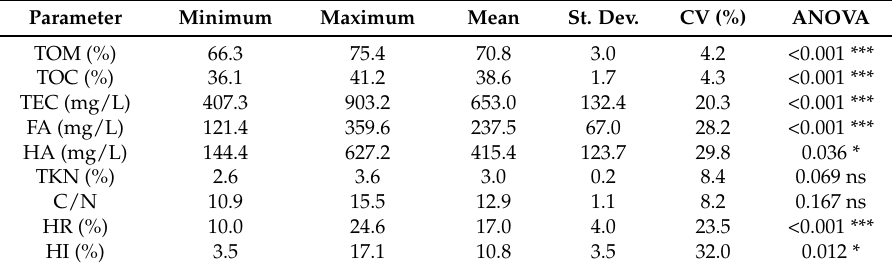
Table 1. Summary statistics of compost analytical parameters and humification ratios for all compost samples ( n = 84). ANOVA results ( p -value and significance level) are shown in the last column.